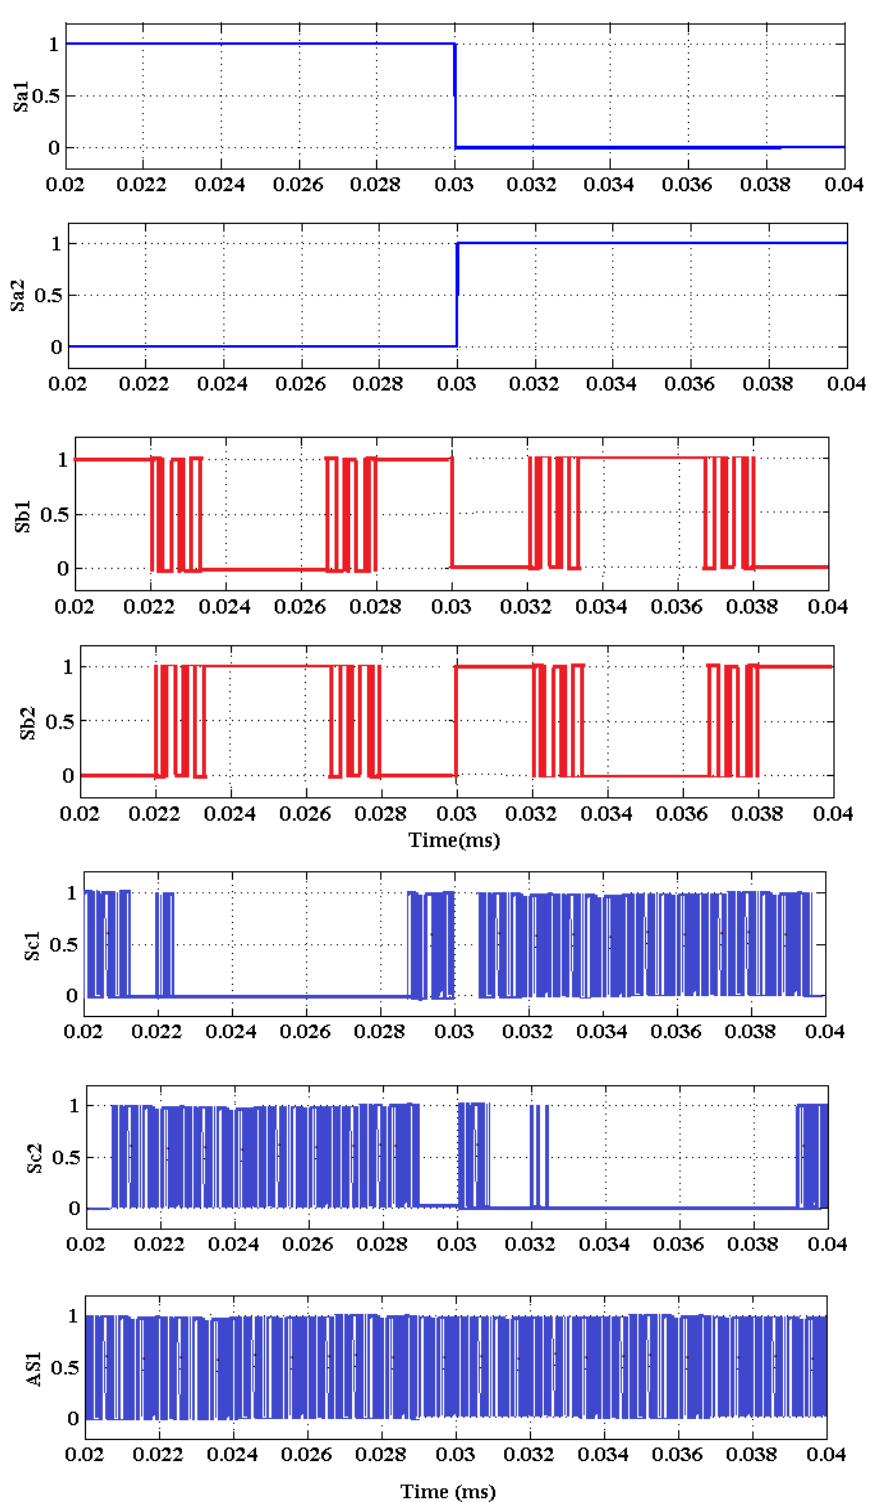
Figure 14. Switching pulses given to the inverter switches.